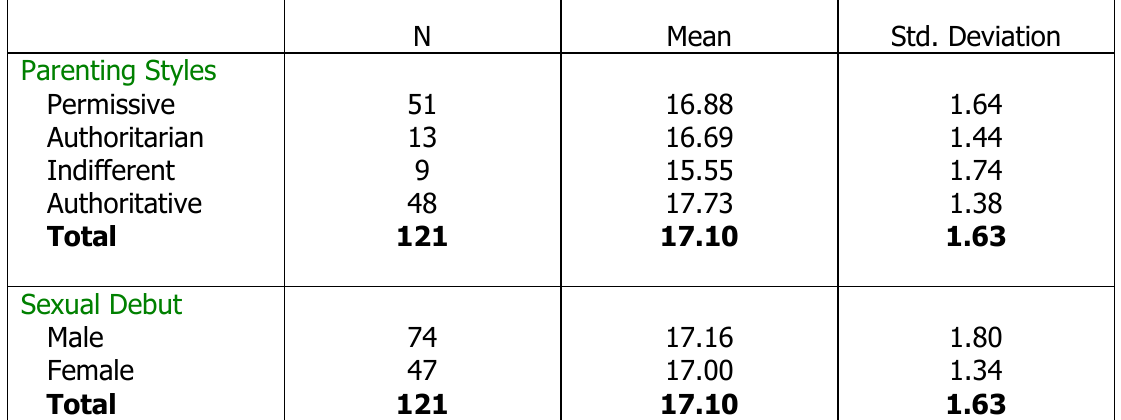
Mean and standard deviation of group who experienced sexual debut (N=121) N Mean Std.